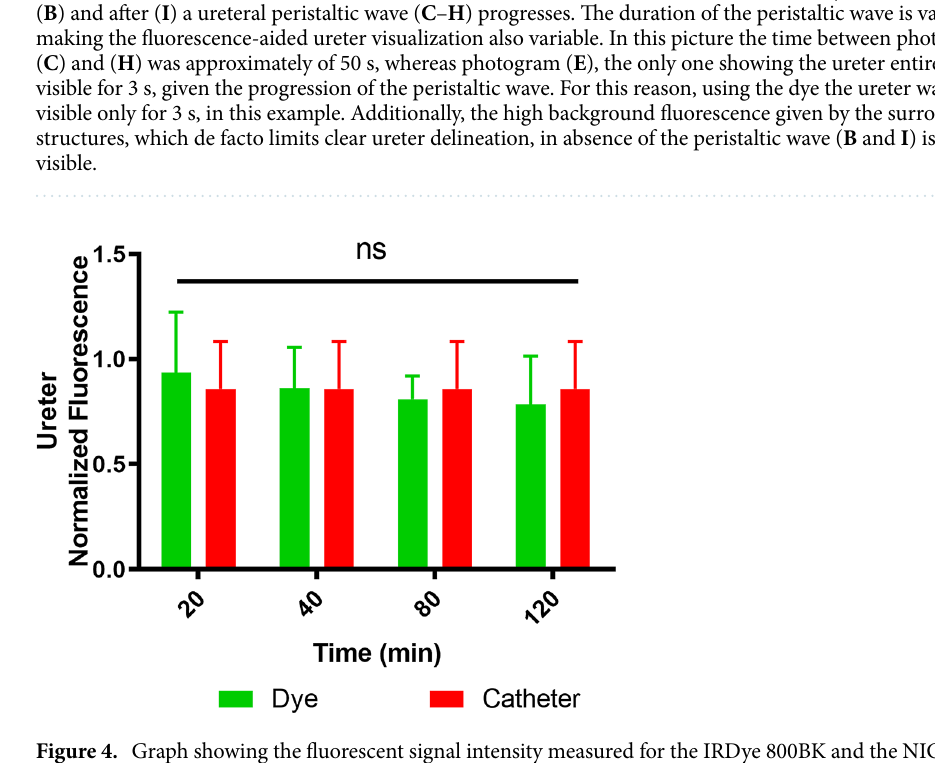
Figure 4. Graph showing the fluorescent signal intensity measured for the IRDye 800BK and the NICE-coated catheter in the porcine model. No statistical difference is